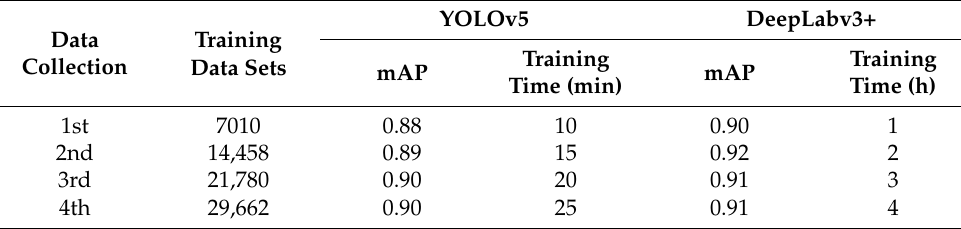
Table 9. The mAP results of YOLOv5 and DeepLabv3+ by data collection period for B1.